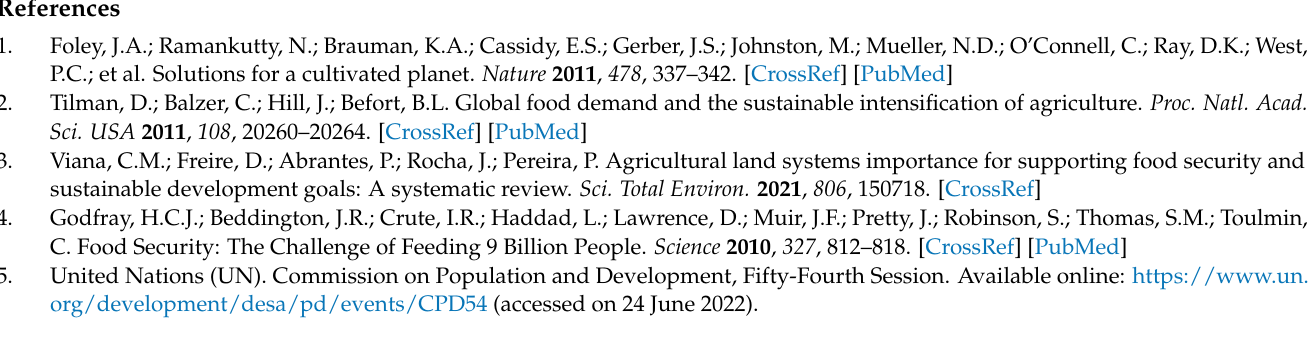
Table S1: Summary of main arable crops and soil types at six regions of China in 2004-2018; Table S2: N content in air-dry grain and straw, ratio of grain to straw and ratio of straw returning for maize, wheat, single rice and double rice in China; Table S3: N content in air-dry grain and straw, ratio of grain to straw and ratio of straw returning for maize, wheat, single rice and double rice in China; Table S4: Livestock feeding period, daily excretion, N content and percentage for field application (based on fresh); Table S5: Nitrogen losses coefficients (%) for different components for each crop and region in China’s croplands; Table S6: Nitrogen (N) input (kg N ha-1) for maize, wheat, single rice and double rice between 2004-2008 and 2014-2018 at the region scale in China farmlands, respectively; Table S7: Nitrogen (N) output (kg N ha-1) for maize, wheat, single rice and double rice between 2004-2008 and 2014-2018 at the region scale in China farmlands, respectively; Table S8: Global warming potential (GWP) for maize, wheat, single rice and double rice between 2004-2008 and 2014-2018 at the region scale in China farmlands, respectively; Table S9: Acidification potential (AP) for maize, wheat, single rice and double rice between 2004-2008 and 2014-2018 at the region scale in China farmlands, respectively; Table S10: The water pollution level of surface runoff emissions (WPL-SR) for maize, wheat, single rice and double rice between 2004-2008 and 2014-2018 at the region scale in China farmlands, respectively; Table S11: The water pollution level of leaching emissions (WPL-LEA) for maize, wheat, single rice and double rice between 2004-2008 and 2014-2018 at the region scale in China farmlands,